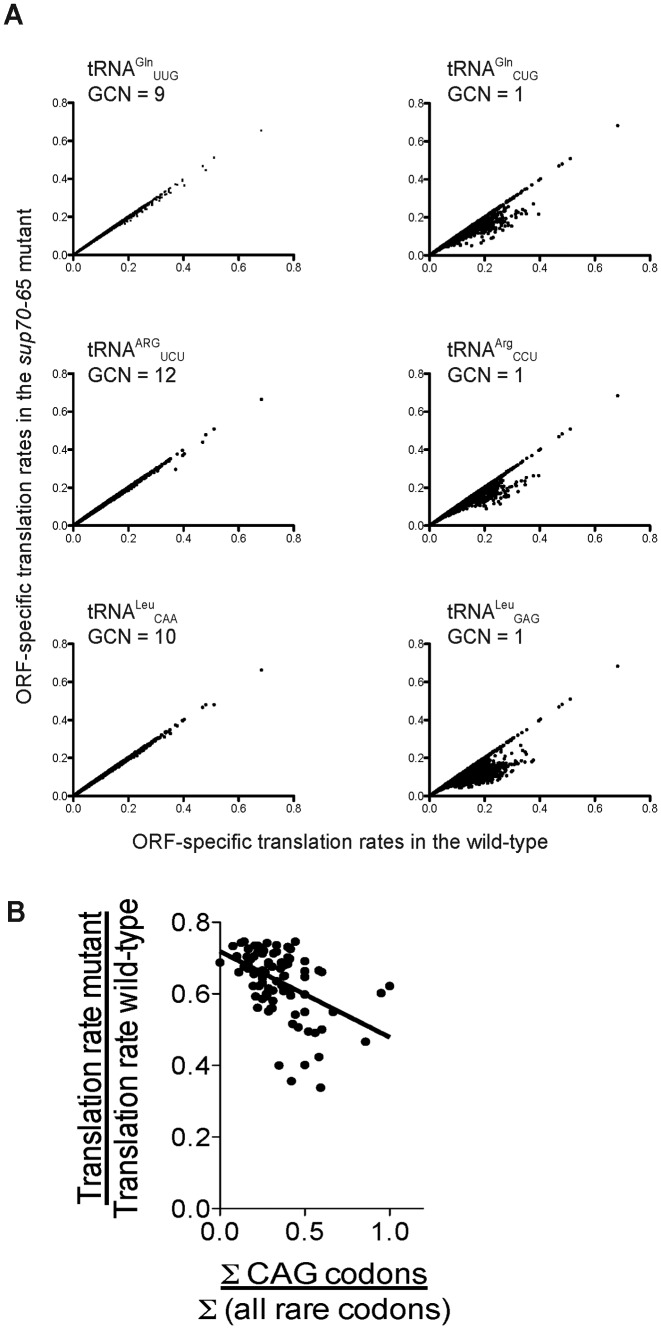
Translation is sensitive to changes in concentrations of rare tRNAs. (A) Translation of all 5500 yeast ORFs was simulated using the TASEP model representing a wild-type spectrum of tRNA concentrations, and again for a simulated cell where the concentration of one tRNA type was reduced to 25% of wild-type levels. The wild-type translation rate for each ORF is plotted against the corresponding tRNA-depleted rate. This exercise was repeated for all 42 species of yeast cytoplasmic tRNA. The results for 6 tRNAs are presented, three types whose encoding genes are multicopy (Gene Copy Number GCN > 4; left column), and three single gene-copy tRNAs (GCN = 1; right column). (B) A disproportionately high content of CAG codons within an ORF, relative to other rare codons, together with the configuration of those CAG codons, may drive ORF sensitivity to \documentclass[12pt]{minimal}
\usepackage{amsmath}
\usepackage{wasysym}
\usepackage{amsfonts}
\usepackage{amssymb}
\usepackage{amsbsy}
\usepackage{upgreek}
\usepackage{mathrsfs}
\setlength{\oddsidemargin}{-69pt}
\begin{document}
}{}${\rm{tRNA}}_{{\rm{CUG}}}^{{\rm{Gln}}}$\end{document} concentrations. To test this, for the 90 most sup70-65 sensitive ORFs, the CAG rare codon content, normalised to content of other rare codons, was plotted against the translation efficiency ratio (sup70-65/wild-type) revealing a negative correlation (R2 = 0.21).